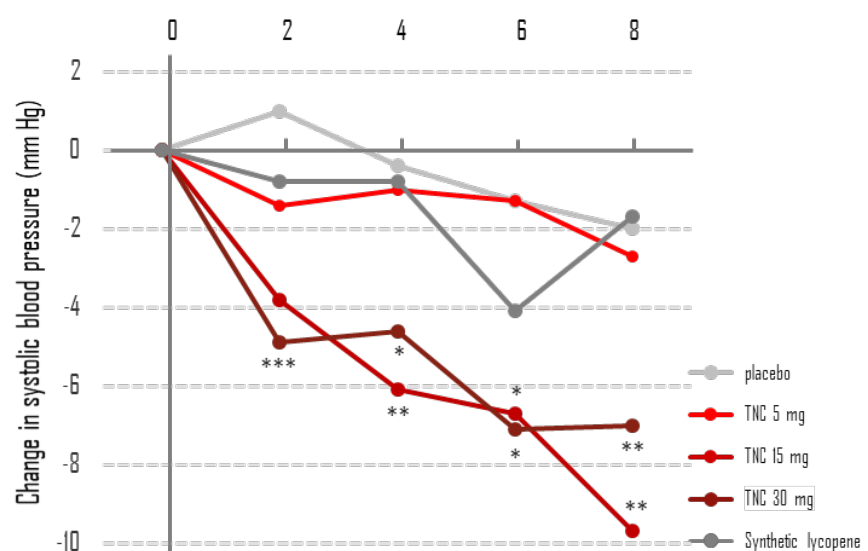
Figure 1. Tomato Nutrient Complex containing 15 mg and 30 mg lycopene reduces systolic blood pressure. Results are the mean of the individual changes from baseline to each time point from two to eight weeks. SDs are not shown for graph simplicity. N is the same as in Table 2. * p < 0.05; ** p < 0.01; *** p < 0.001 for changes to baseline within treatment arm.